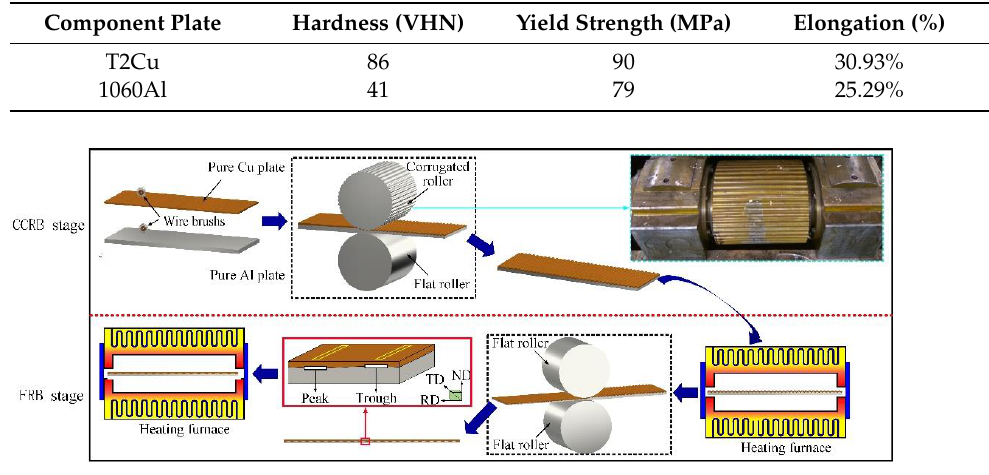
Figure 1. The schematic diagram of CFR technique.